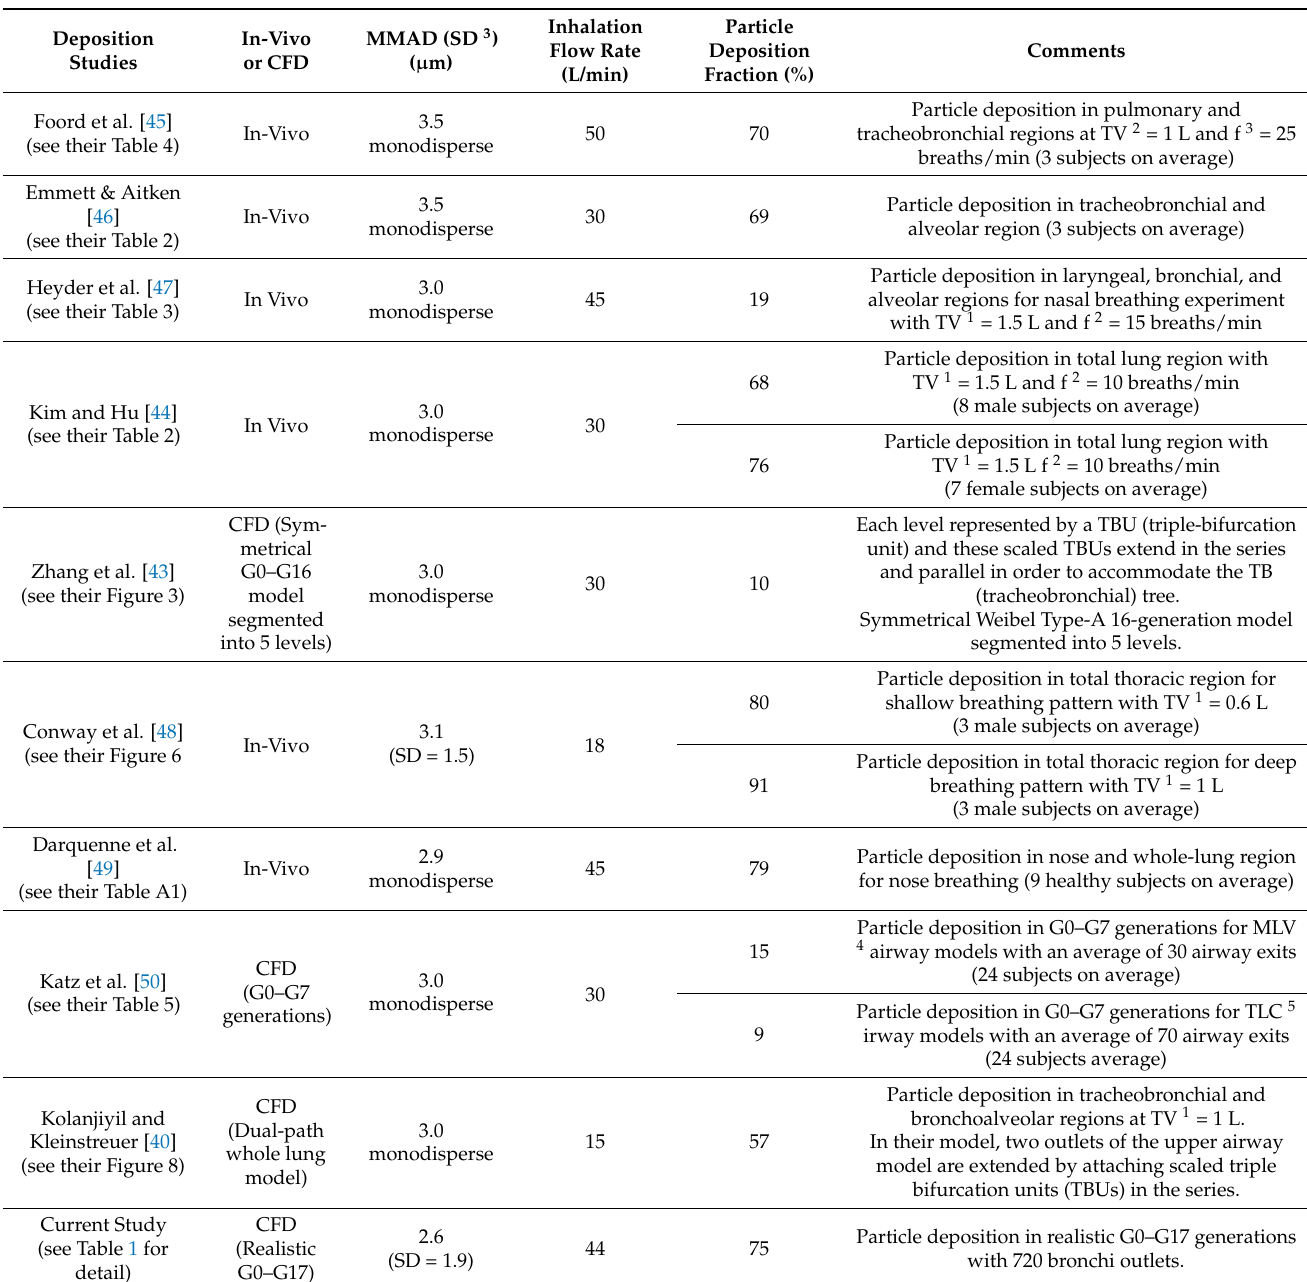
Table 2. Comparison of the total thoracic particle deposition with the available in vivo experiments and CFD models for 2.5–3.5 µ m particles (chronological